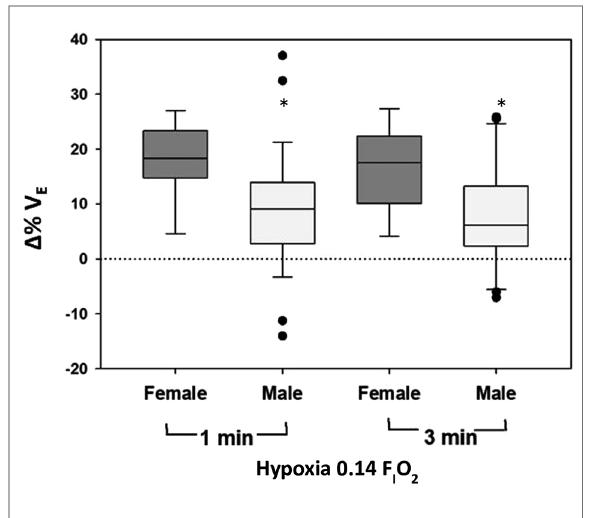
FIGURE 4 Change (% from baseline) in minute ventilation ( V E ) during hypoxia is shown as a function of